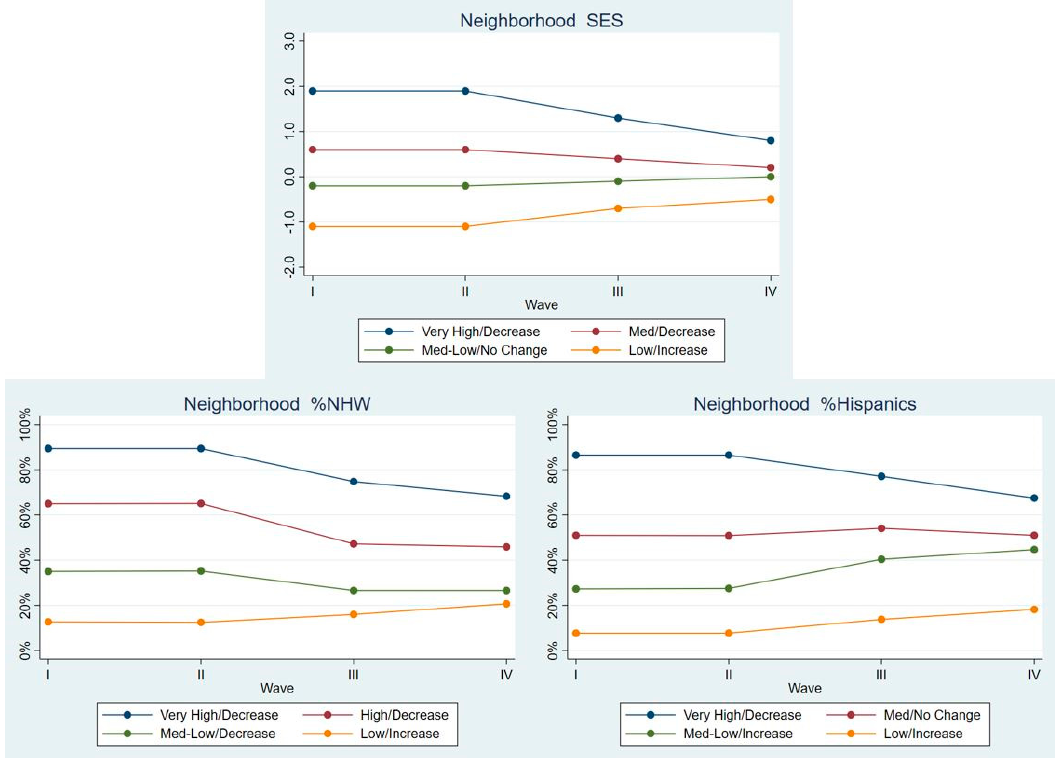
Figure 3. Latent class means for each neighborhood characteristic by Wave, Hispanics. Int. J. Environ. Res. Public Health 2020 , 17 , x